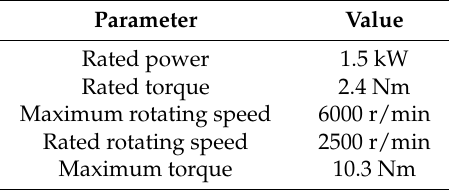
Figure 8. MiniHiL test bench. Table 7. Electric motor parameters.